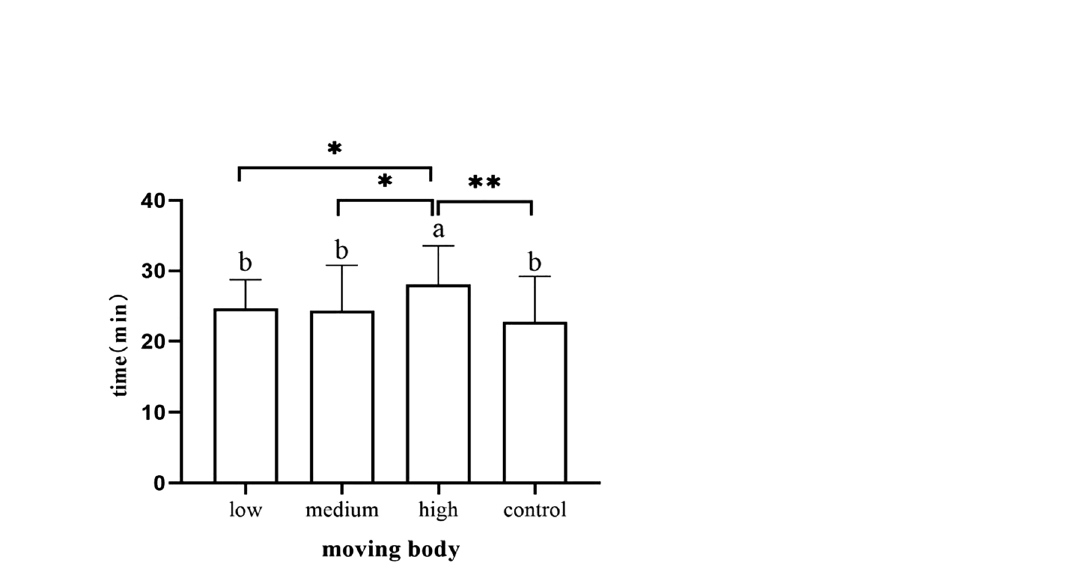
Figure 5. Occurrence time of moving